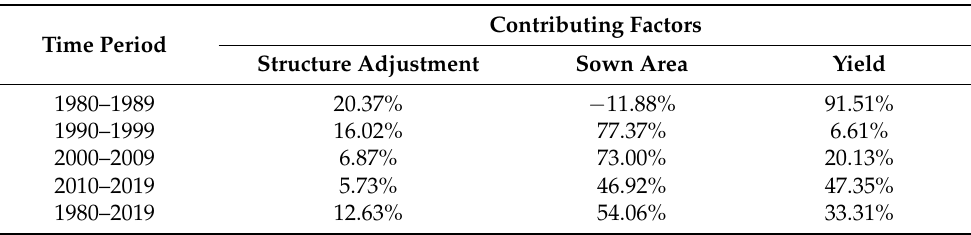
Table 3. Contribution of the grain-production increases in different varieties of crops to the grain production of Inner Mongolia Autonomous